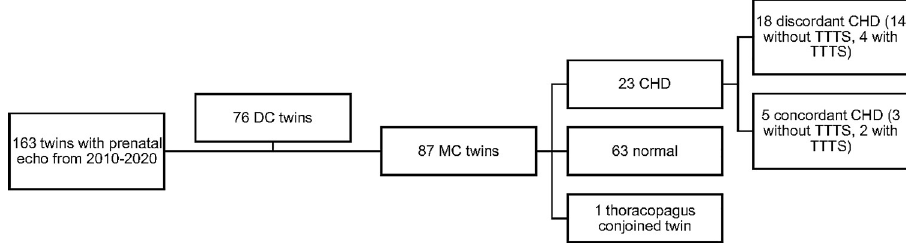
Fig 1. Study population of twins evaluated. DC, dichorionic; MC, monochorionic; CHD, congenital heart defects; TTTS, twin-to-twin transfusion syndrome.